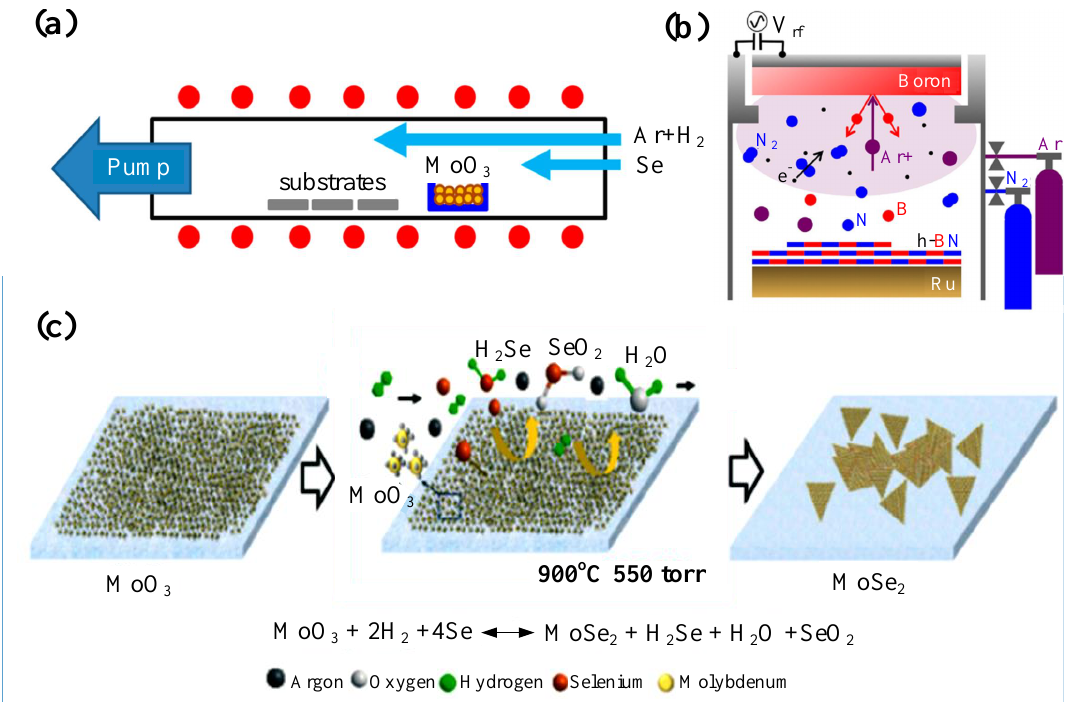
Figure 6. The preparation of 2D materials based on deposition methods. ( a ) Schematic of layered MoSe 2 grown by CVD. Adapted with permission from reference [137]. Copyright 2010 American Chemical Society. ( b ) Schematic of BN films grown by MSD. Adapted with permission from [140]. Copyright 2012 American Chemical Society. ( c ) Schematic of MoSe 2 monolayer grown by PLD and selenidation techniques. Adapted with permission from [141]. Copyright 2016 The Royal Society of